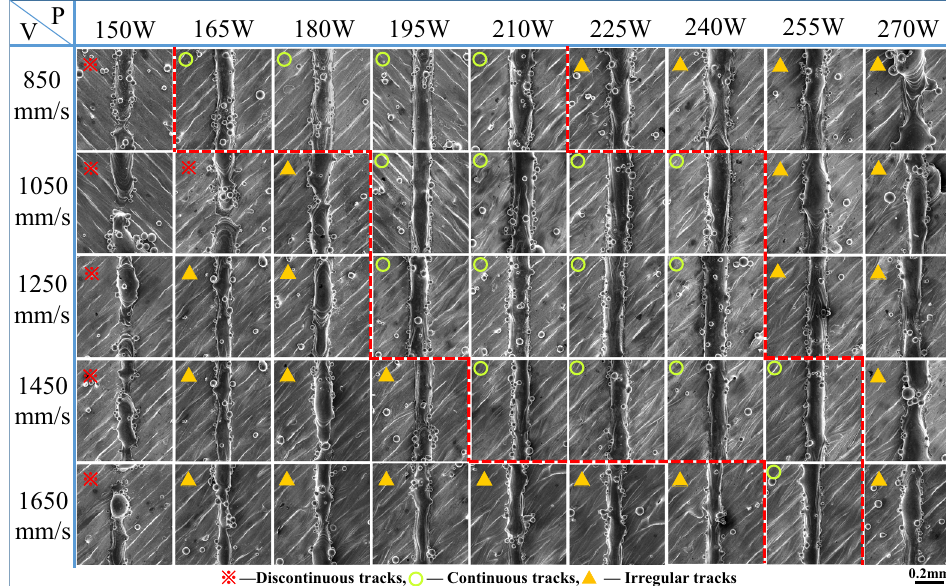
Figure 3 LPBF process window of Ti-6.5Al-3.5Mo-1.5Zr-0.3Si alloy